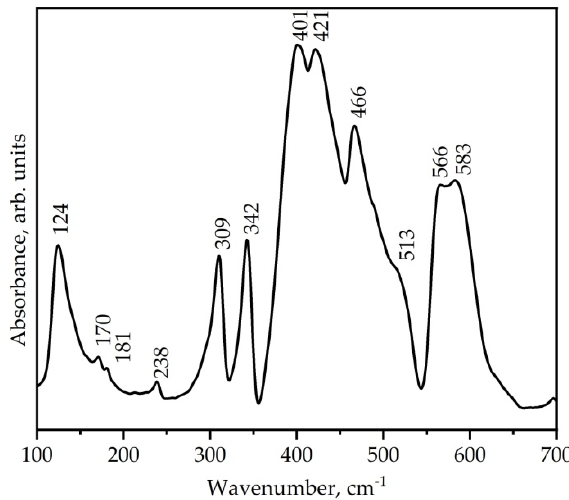
Figure 3. IR absorption spectrum of Er (0.5 mol.%):Y 2 O 3.